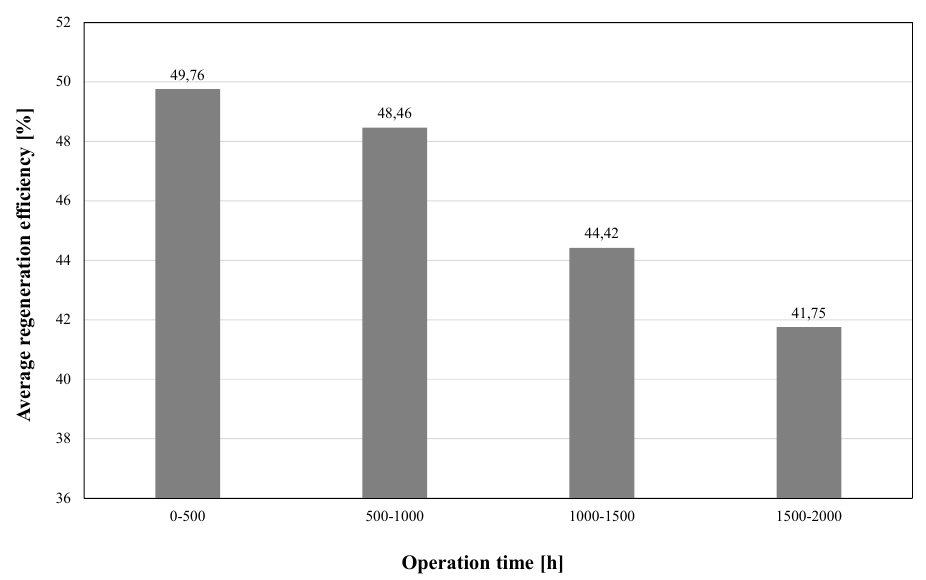
Figure 3. Average efficiency of the USR-I regenerator demonstrated in long-term studies.